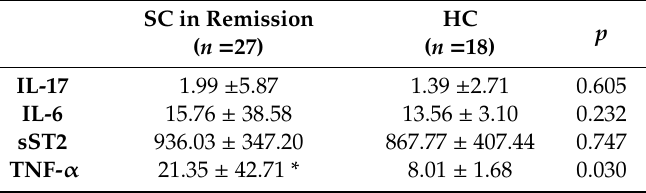
Table 2. Cytokine concentrations (pg / mL; mean ± SD).